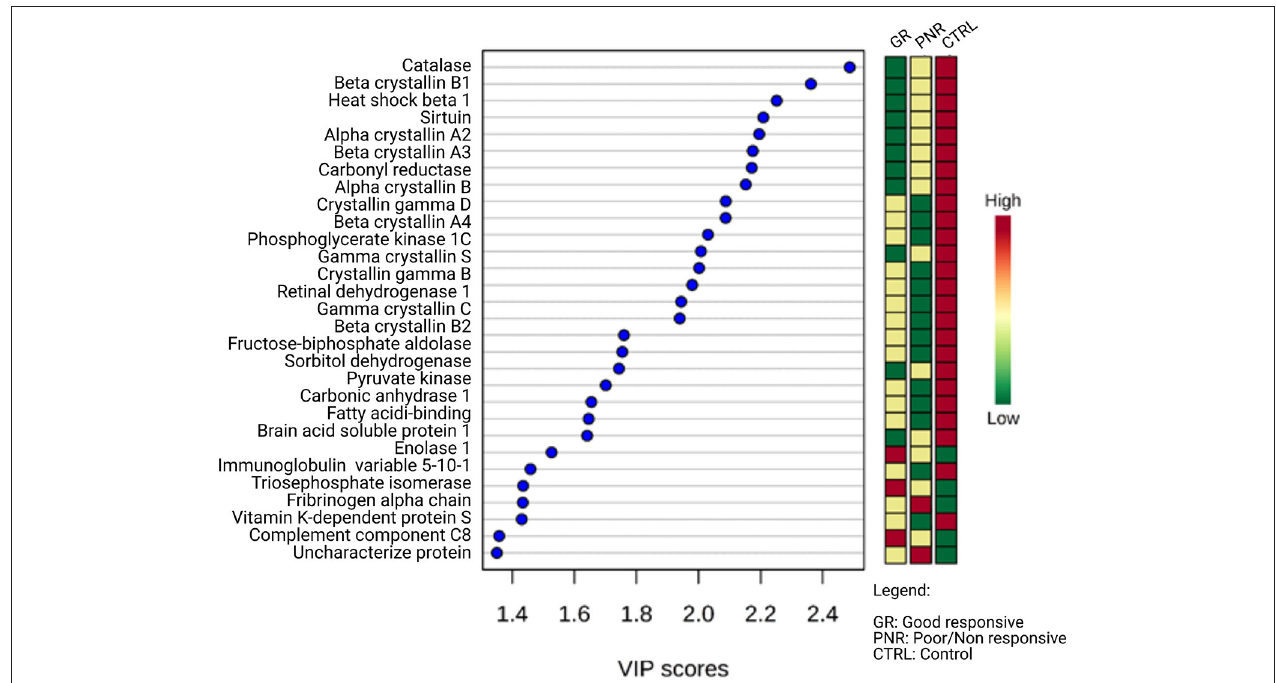
FIGURE 5 | Multivariate analyses by VIP scores of regulated proteins in aqueous humor of patients with good responsive nAMD, poor/non-responsive nAMD, and control patients (PLS-DA imp. features). Among the 30 regulated proteins with the highest VIP score, 25 have negative regulation in pathological scenarios. The colored boxes on the right indicate the relative intensity of each protein in the respective